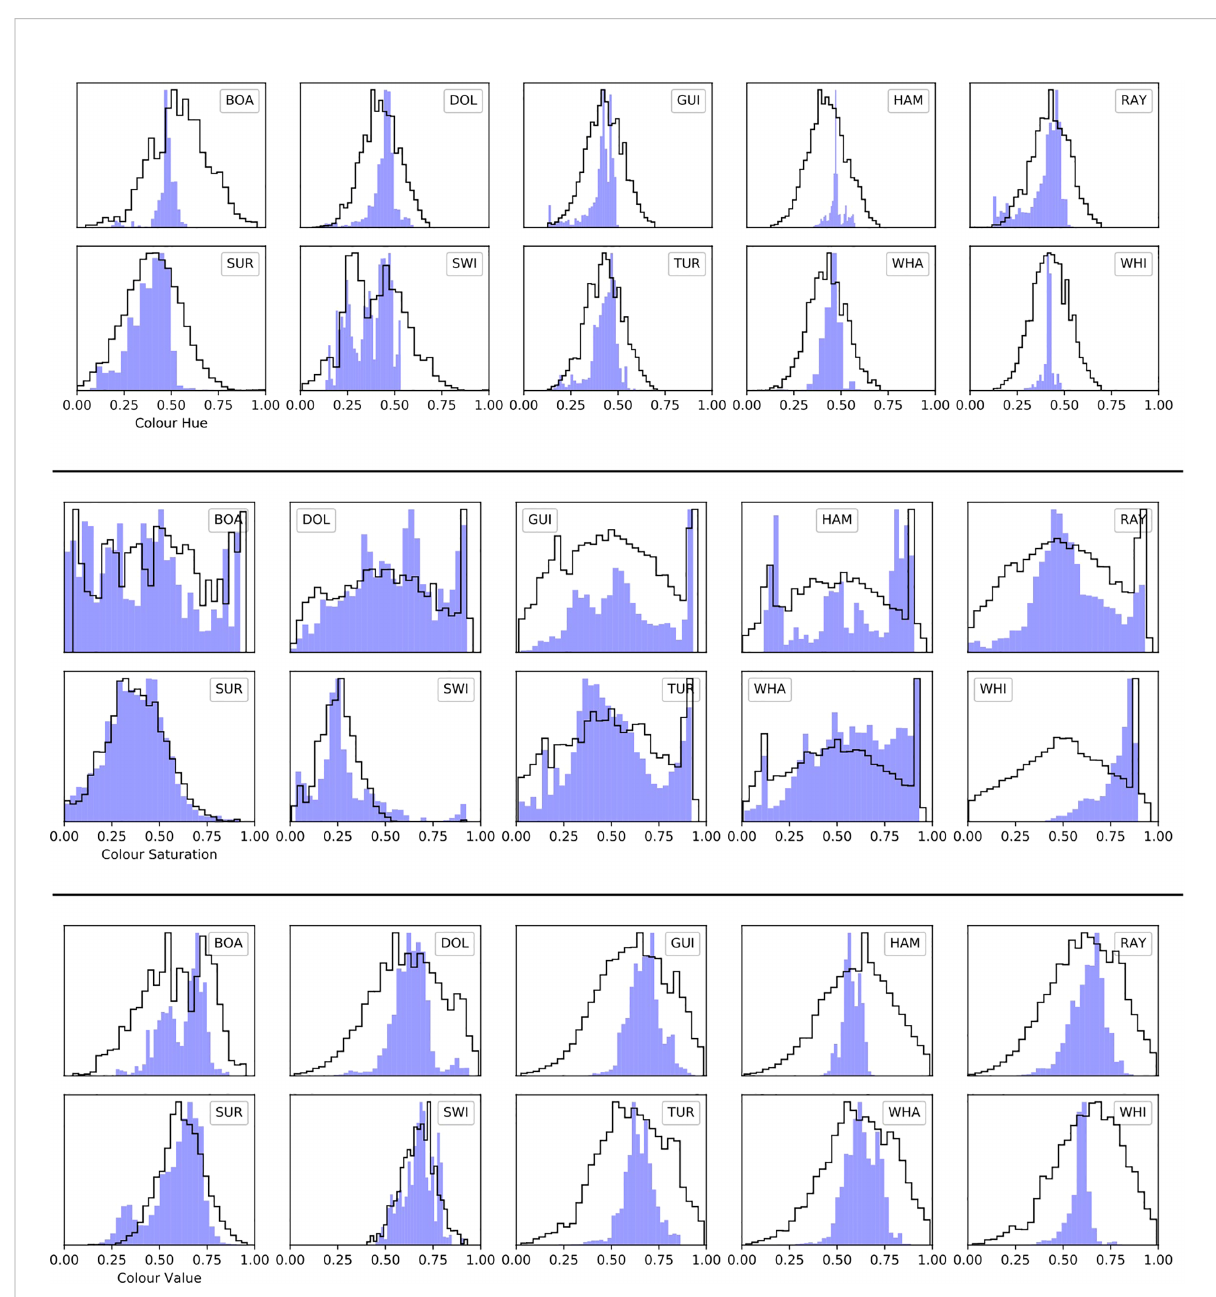
FIGURE 5 Distributions of median colour hue (top), colour saturation (middle) and colour value (bottom) for training images in all ten classes. Hue values cluster near to H ≈ 0.4, which encodes the average colour of the sea as green. Colour value and saturation encode brightness and colour intensity, respectively. In each panel the blue- fi lled histogram shows the distribution before normalisation, while the black outline histogram shows the distribution after applying the colour normalisation scheme described in § 3.3. After normalisation, colours are more similar between classes and sample a larger range of parameter